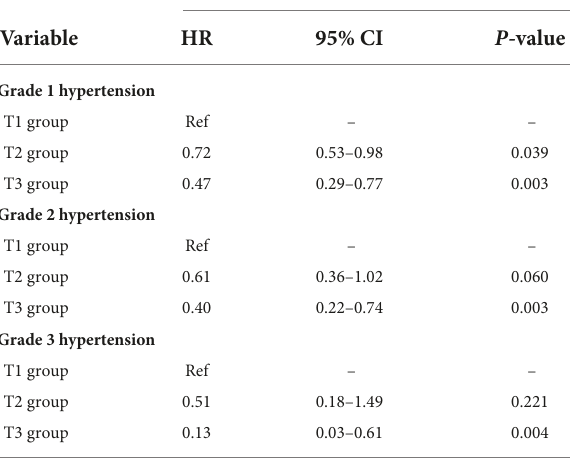
TABLE 3 All-cause mortality hazard ratios (HRs) in different grade of hypertension.